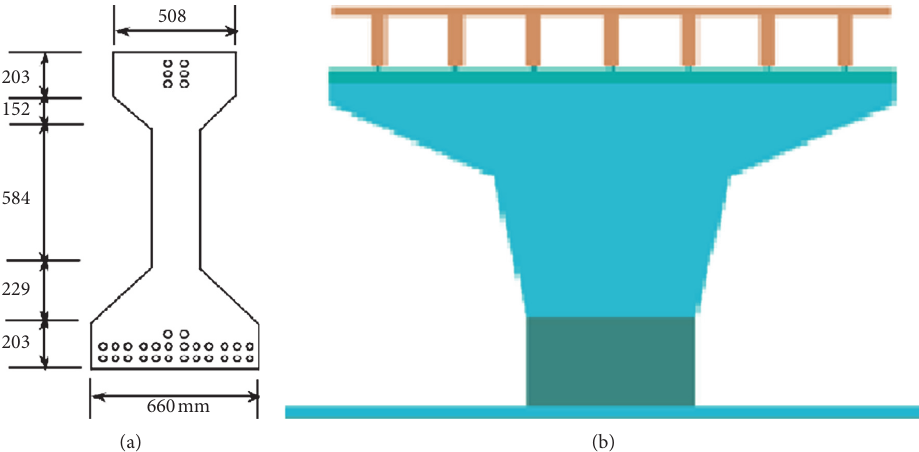
Figure 8: Hongqi Bridge with concrete girder-slab: (a) girders’ properties according to AASHTO and (b) modeling in AEM.